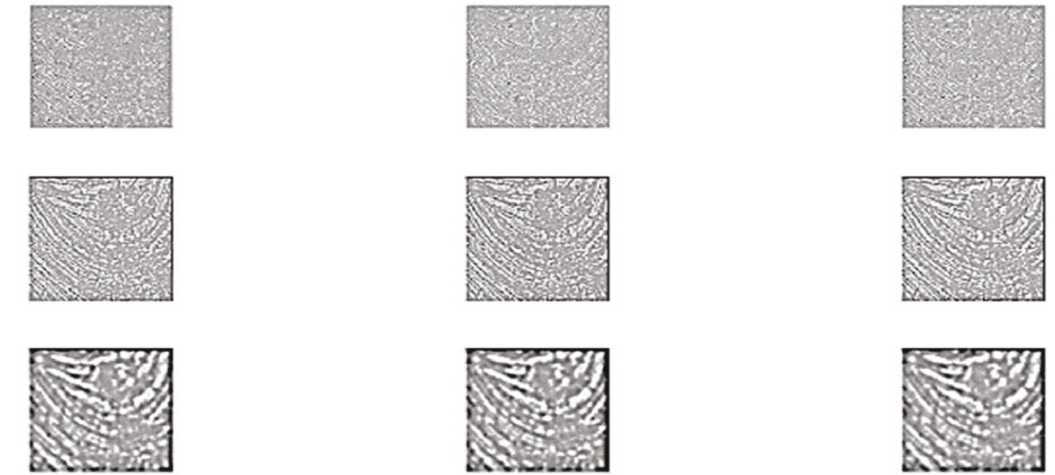
Figure 10: Output graph showing key points that do not match.